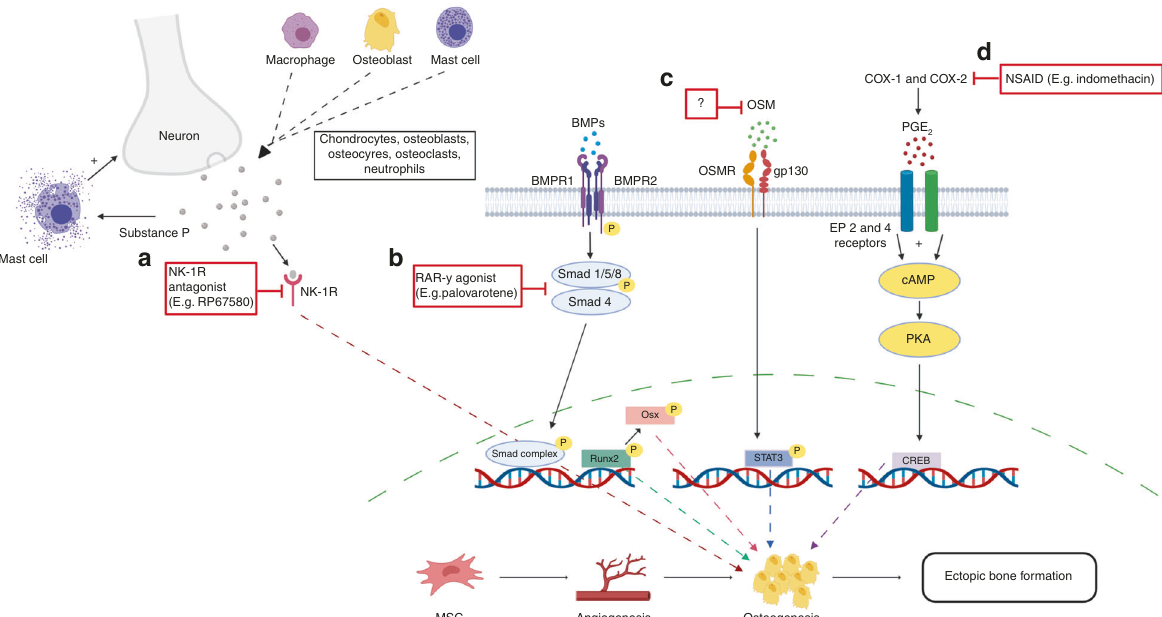
Fig. 3 Key pathways/mechanisms implicated in the development of NHO highlighting potential and existing therapeutic targets to mitigate NHO. a Substance P receptor (NK- 1 R) antagonists (e.g. RP67580) have been found to reduce NHO volume in murine models. b Downstream of the BMP pathway, RAR- γ agonists such as palovarotene have been reported to prevent early stages of NHO development by disrupting OPC differentiation, chondrogenesis and osteogenesis by downregulating mRNA expression of SOX-9 and RUNX2. c OSM is a potential therapeutic target and may serve as a biomarker for NHO. Blocking OSM has been found to reduce NHO likely by inhibiting downstream transcription factor, STAT3, which is known to trigger bone formation. d NSAID, indomethacin is currently the preferred prophylaxis for NHO/HO. It targets COX-1 and COX-2 non-selectively, inhibiting the production of prostaglandins and osteogenesis (created with